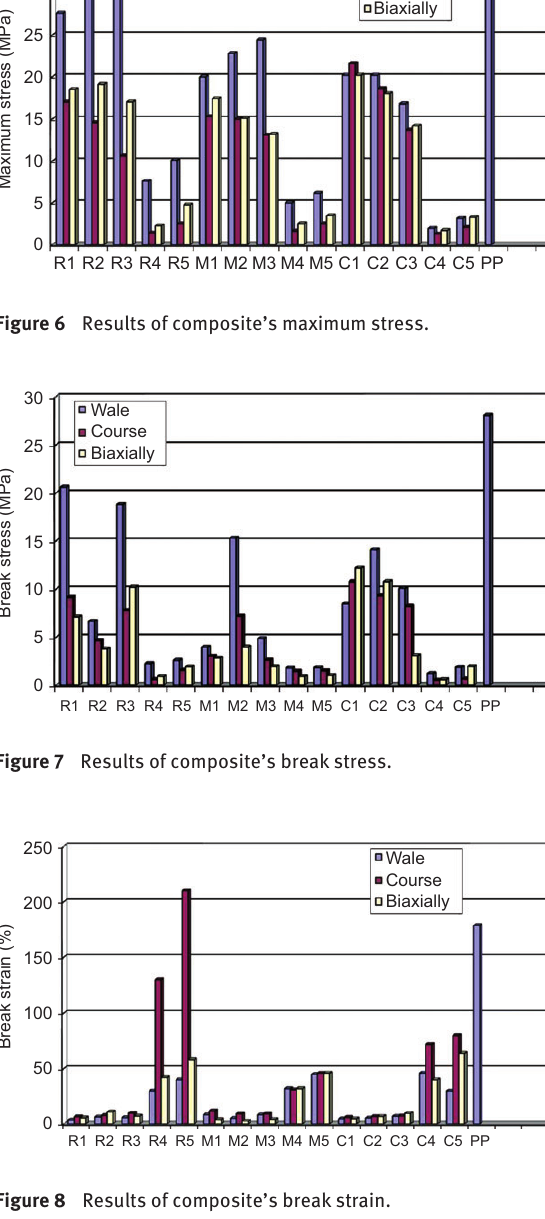
Figure 5 Results of composite ’ s yield strain.